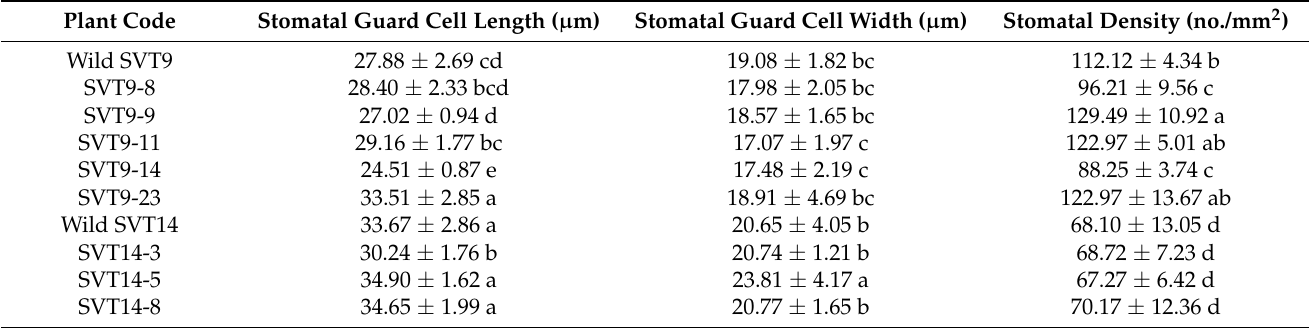
Table 3. Stomatal differences among the in vitro-regenerated caladium variants and their correspond- ing wild